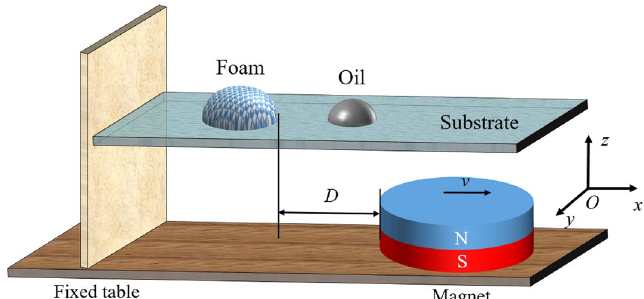
Figure 1. Schematic diagram of the experimental setup.